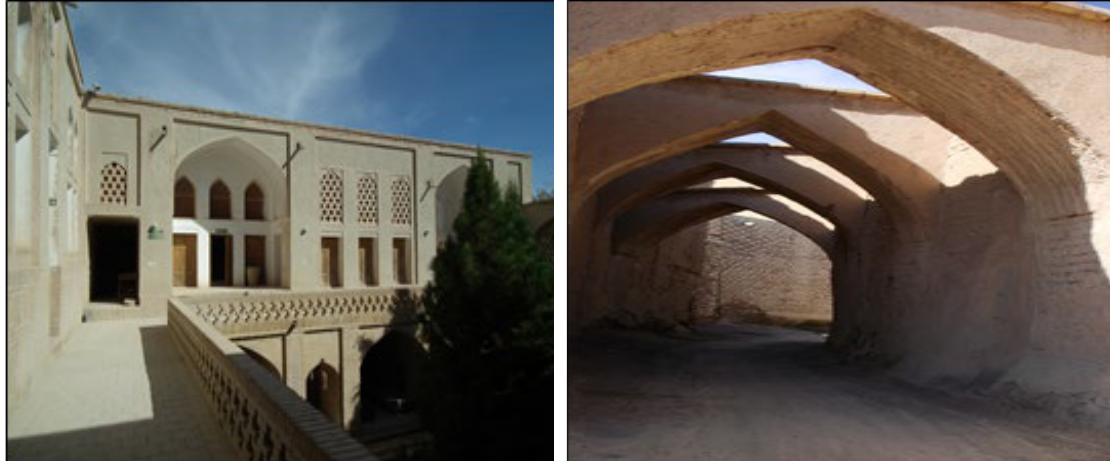
Fig. 5: Introversion of private and public buildings View from inside the Pirnyia house